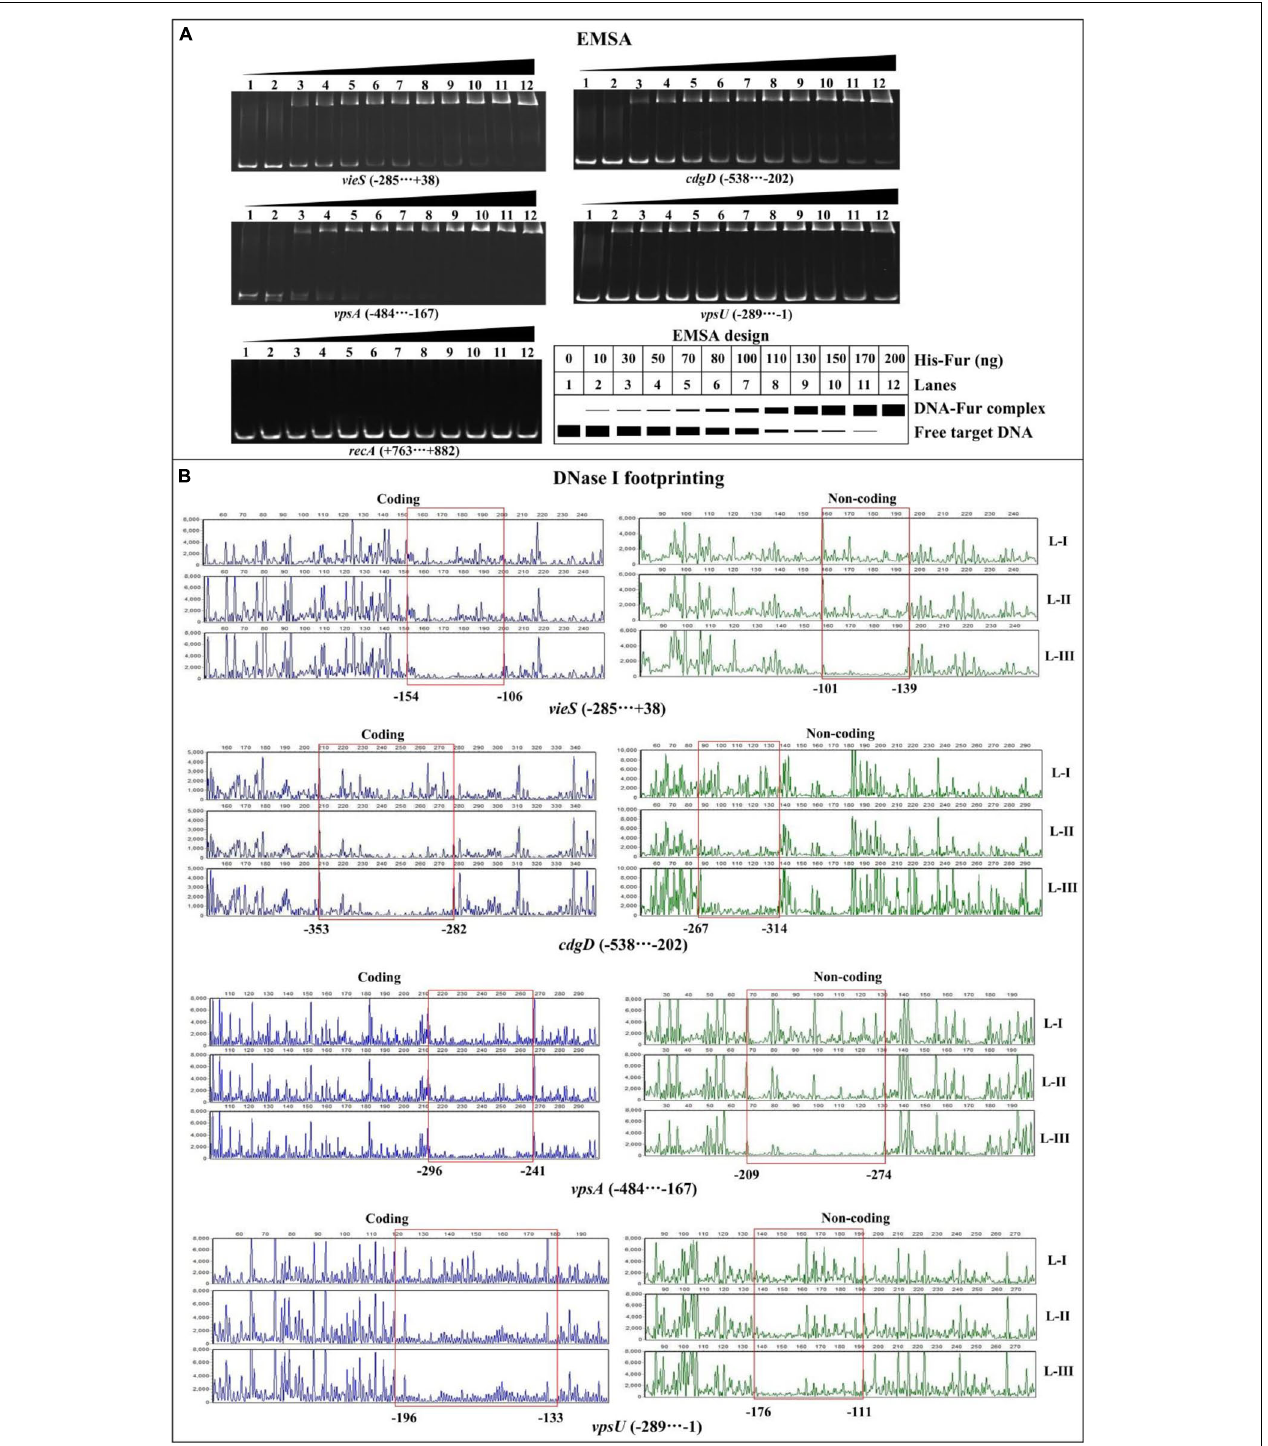
FIGURE 4 | Binding of Fur to the target promoters. The negative and positive numbers indicated the nucleotide positions upstream and downstream of indicated genes, respectively. (A) Electrophoretic mobility shift assay (EMSA). The promoter-proximal DNA fragments of each target gene were incubated with increasing amounts of His-Fur and then subjected to 6% (w/v) polyacrylamide gel electrophoresis. The DNA bands were visualized by GelRed staining. Schematic representation of the EMSA design was shown below. (B) DNase I footprinting assay. Fluorescently labeled DNA probes were incubated with increasing quantities of His-Fur (Lanes-I, II, and III contain 0, 2.95, and 8.85 pmol, respectively) and digested with DNase I. Results were analyzed with an ABI 3500XL DNA analyzer. Footprint regions are boxed and marked with positions.